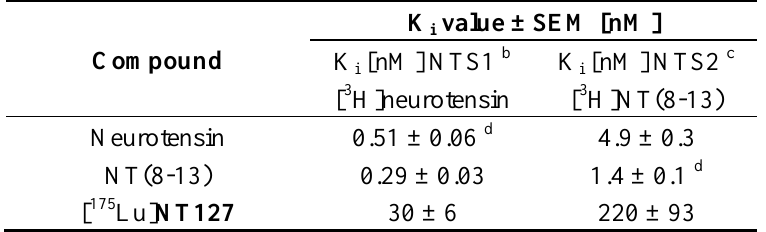
Table 1. Receptor binding data of [ 175 Lu] NT127 in comparison with the reference ligands neurotensin and NT(8-13) employing human NTS1 and NTS2 a